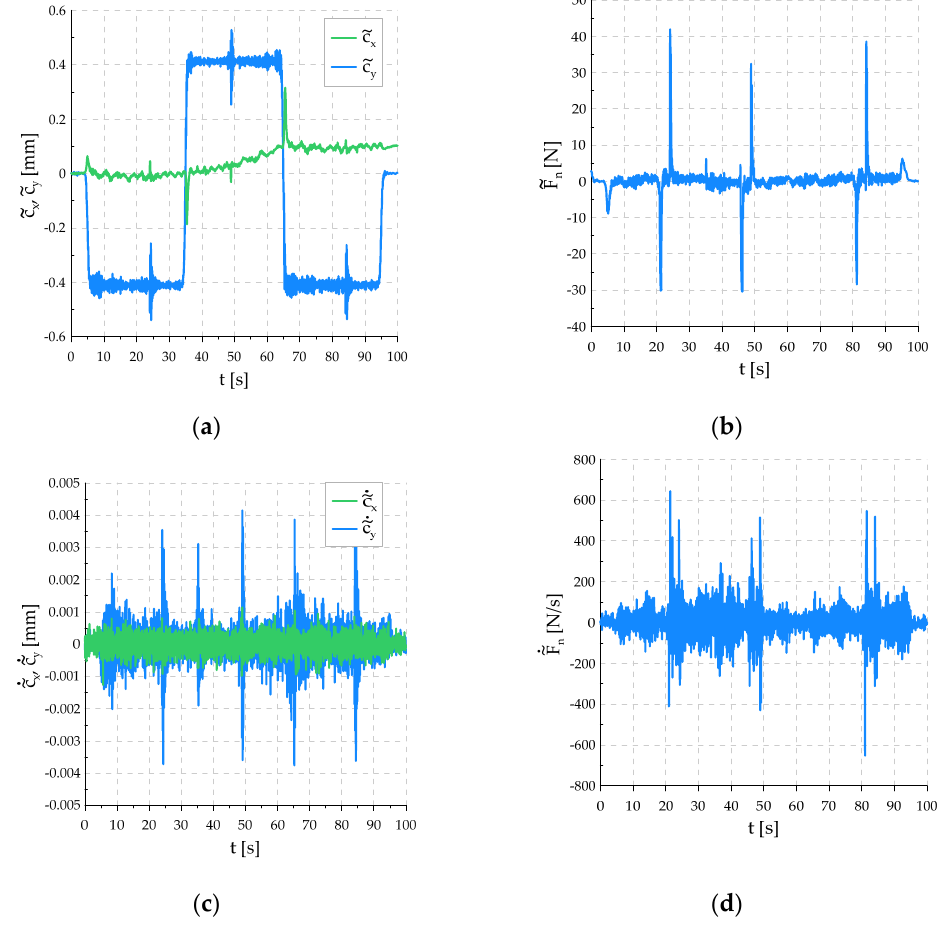
Figure 11. Lag errors: ( a ) TCP displacement errors in directions tangent to the surface of the workpiece; ( b ) downforce error; ( c ) TCP velocity errors in tangent directions; ( d ) derivative of downforce force error.